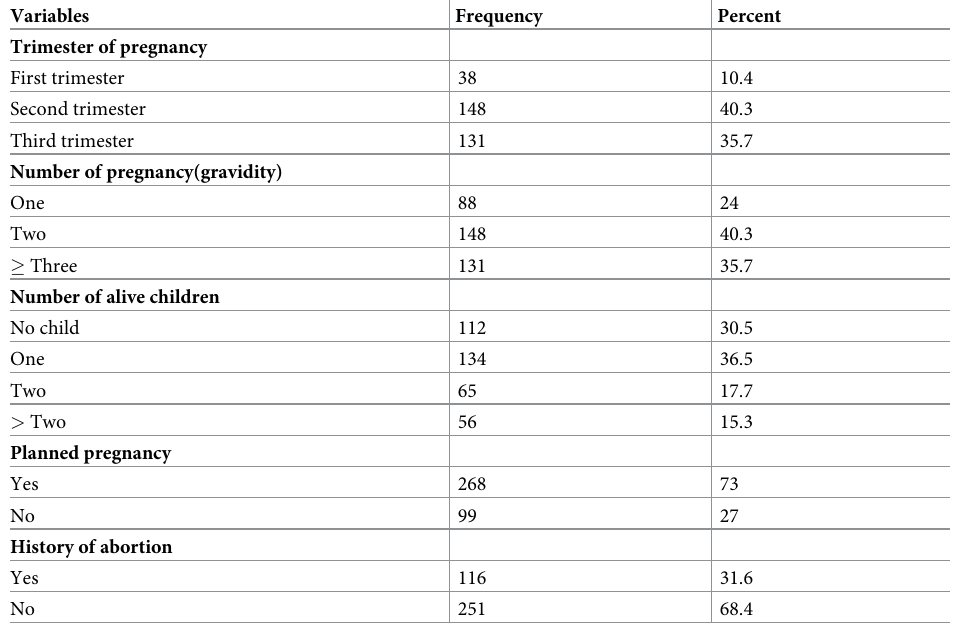
Table 2. Obstetric history of the pregnant women in kolfe Keranio sub city (n = 367) Addis Ababa, Ethiopia.